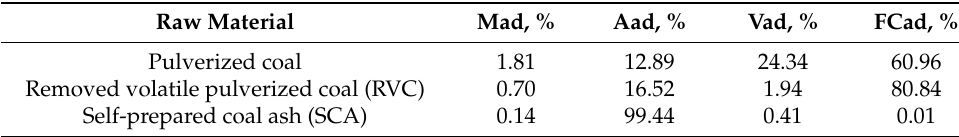
Table 2. Proximate analysis results of pulverized coal, RVC, and SCA (%).